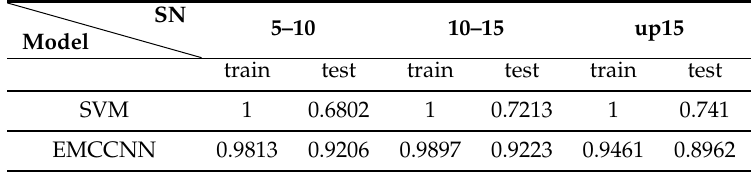
Table 2. Classification accuracy of different network